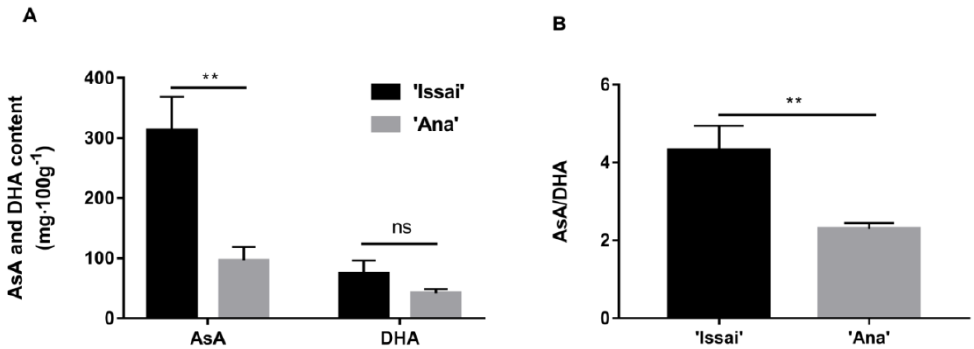
Figure 4. The content of AsA and DHA ( A ), and AsA/DHA ratio ( B ) at 84 DAF. The data are presented as mean ± standard error from three biological replicate assays (** p < 0.01). The error bars represent standard error of the means.